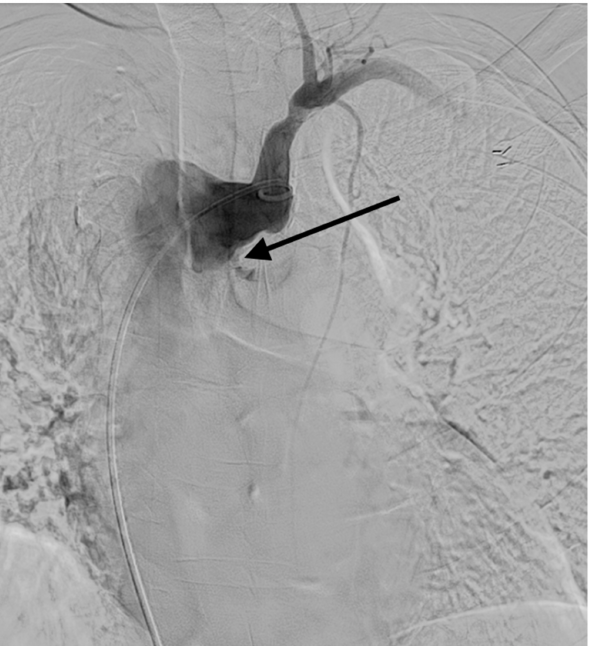
Figure 5. The arteriogram obtained after contrast injection at the ostium of the left subclavian artery confirmed the extravasation (arrow) from the diverticular segment of the aberrant left subcla- vian artery.